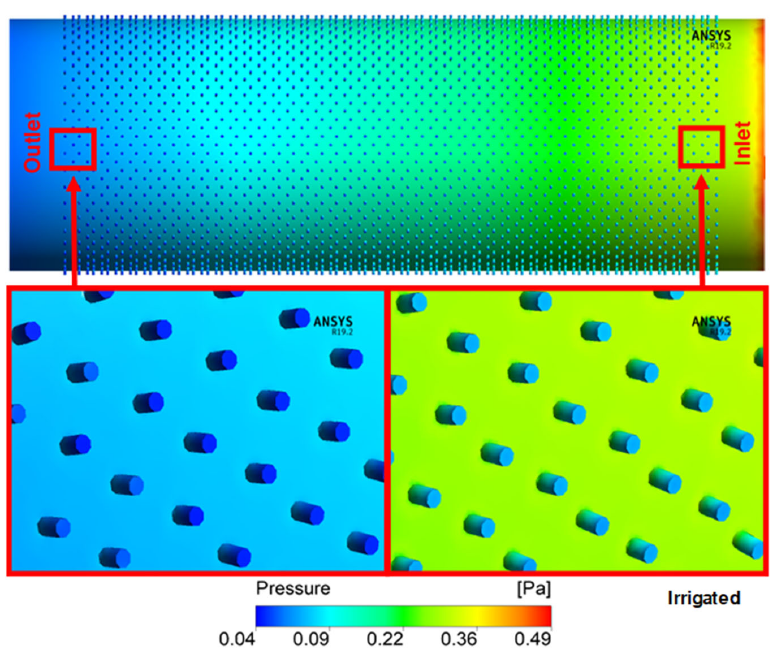
Figure 5. Flow field pressure distribution in section along the axis of irrigated vessels.